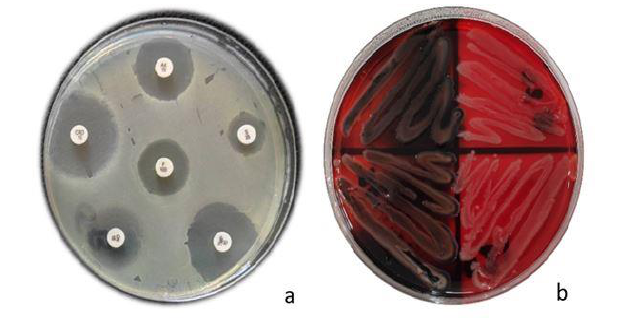
Fig. 2: Antibiotic test on Mueller–Hinton agar (a) and biofilm production test for E.coli on CRA(b).